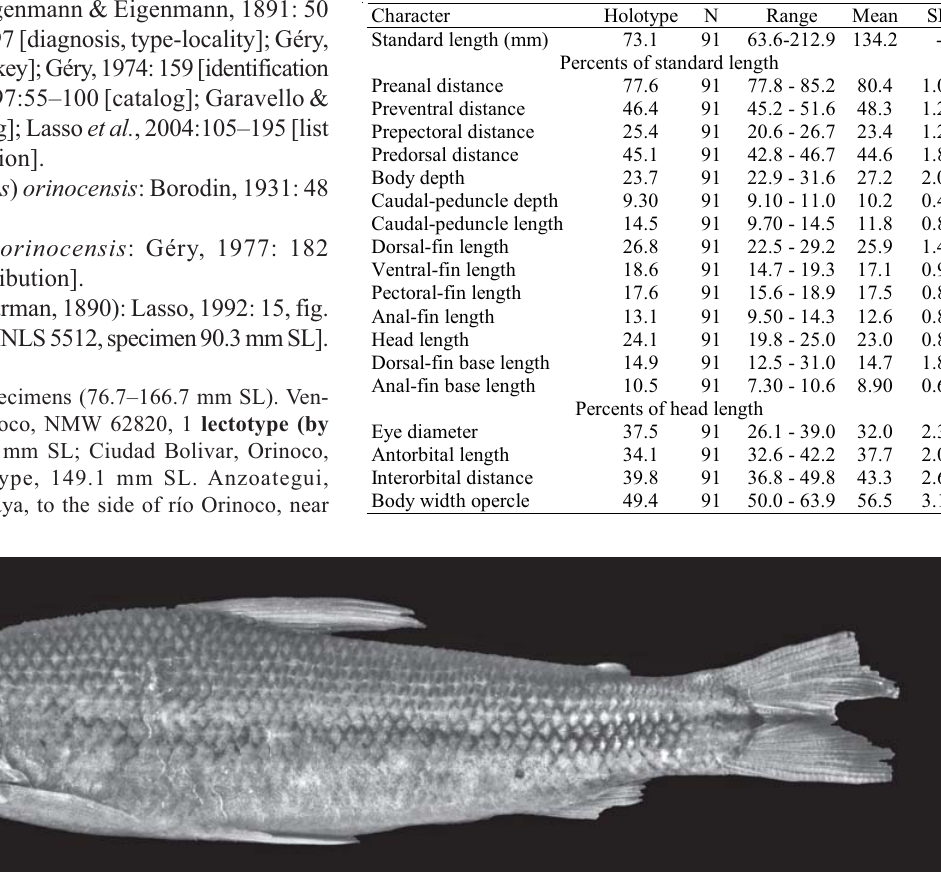
Fig. 16. Laemolyta orinocensis , NMW 62820: 1, lectotype, 166.7 mm SL; Venezuela, Ciudad Bolivar, río